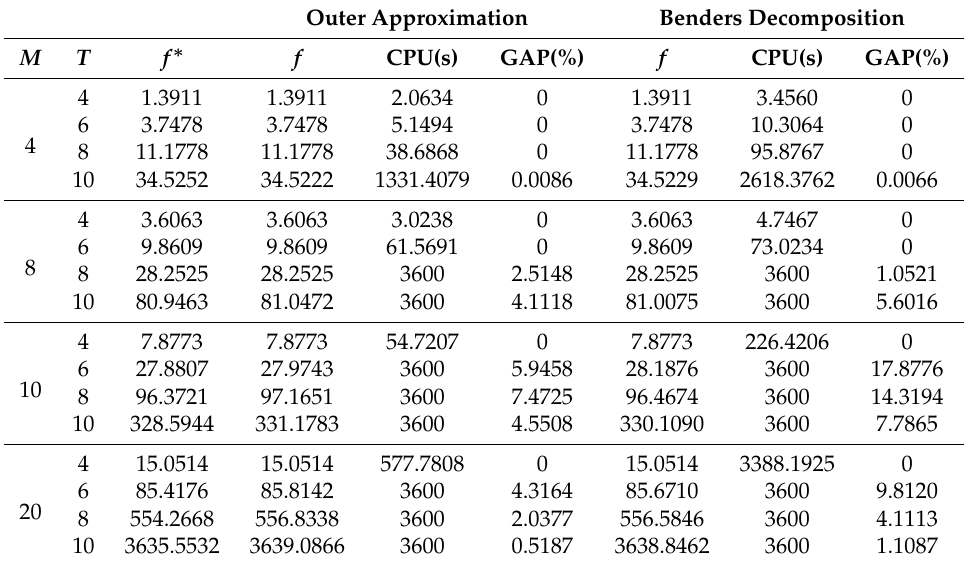
Table 3. Computational analysis of the Outer Approximation and Benders decomposition. Outer